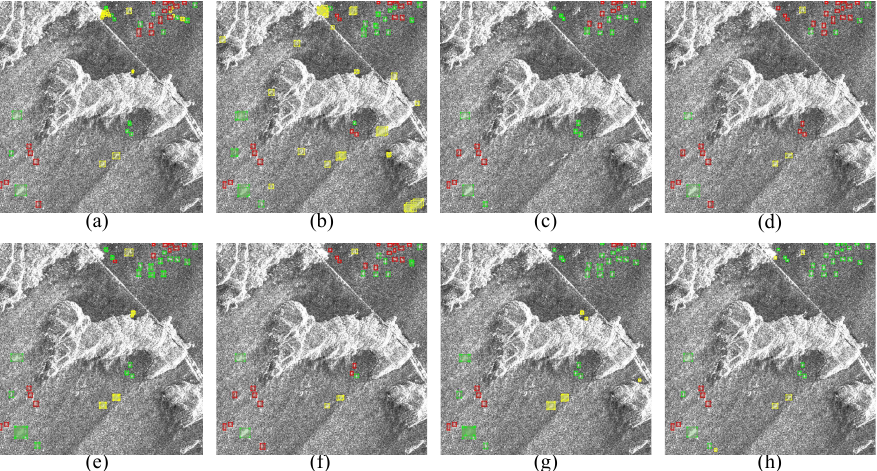
Figure 13. Visualization of detection results with different detectors in scene 4. ( a ) RetinaNet. ( b ) ATSS. ( c ) YOLOv5. ( d ) Faster R-CNN. ( e ) Double-head R-CNN. ( f ) Cascade R-CNN. ( g ) Dynamic R-CNN. ( h ) The proposed